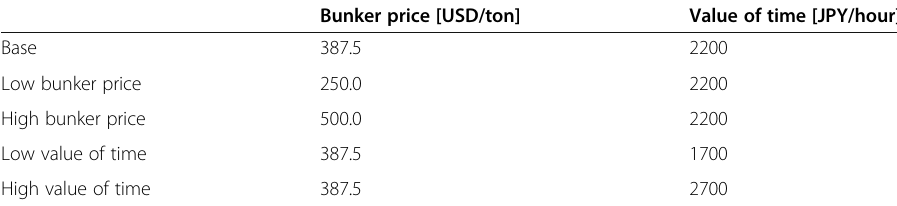
Table 2 Detailed conditions of the scenarios for sensitivity analysis